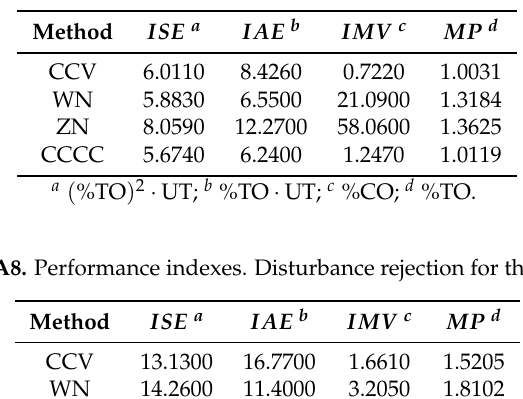
Table A7. Performance indexes. Set-point tracking for the set P 3 .